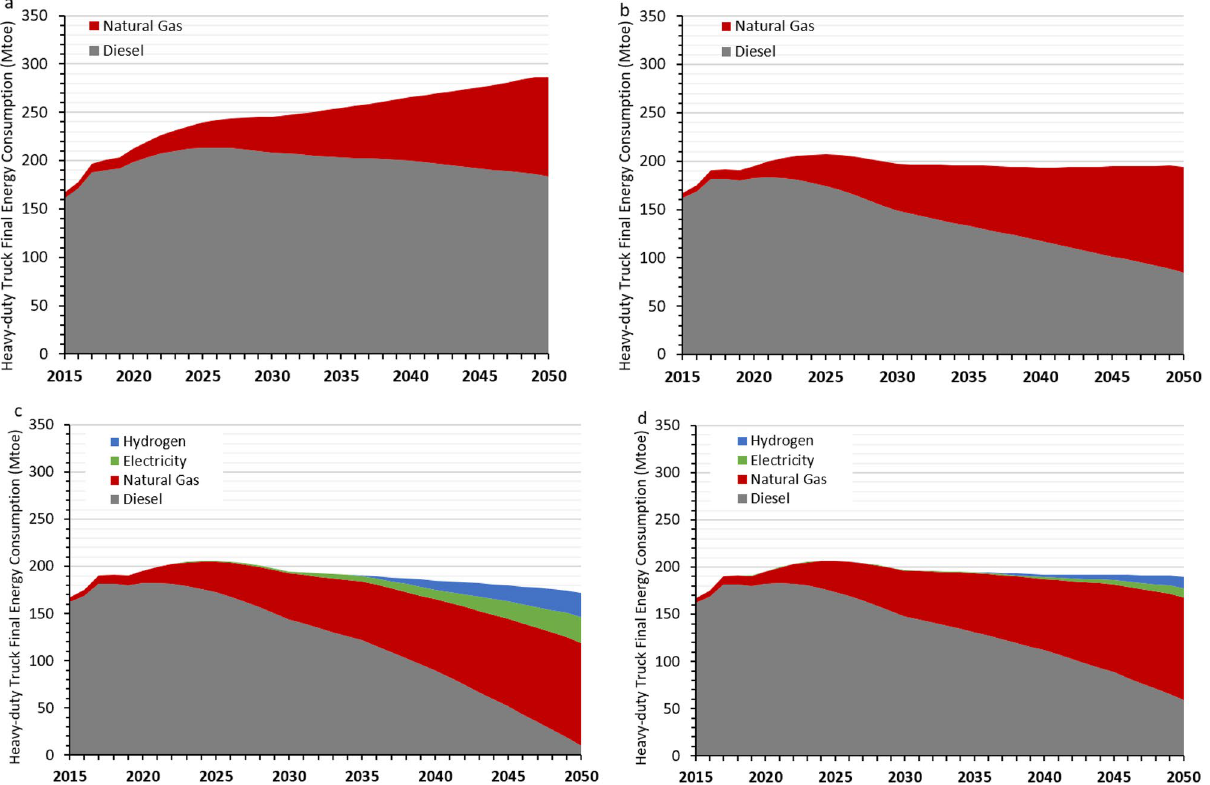
Figure 1. China’s heavy-duty truck fleet final energy consumption results under ( a ) reference scenario; ( b ) short-term strategies scenario with energy-efficiency and logistics improvements and LNG fuel switching; ( c ) NEV early adoption scenario; and ( d ) NEV late adoption